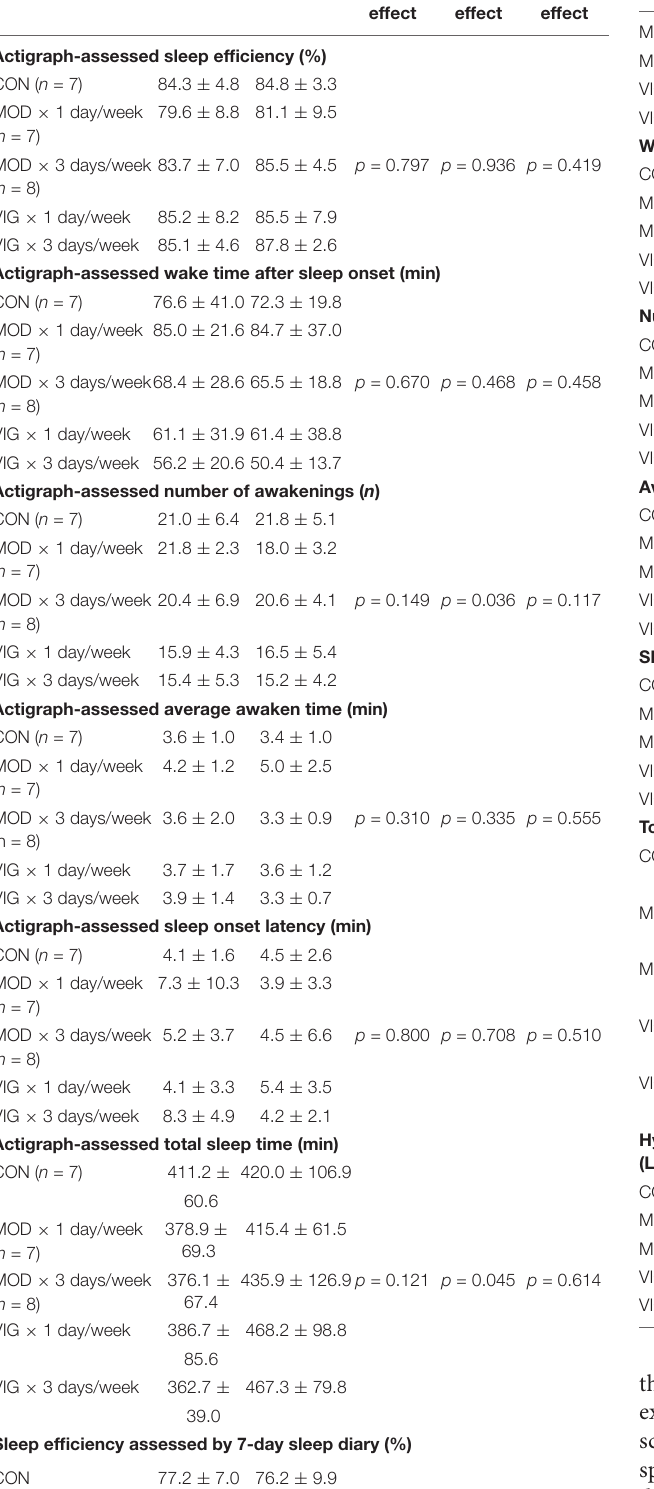
TABLE 2 | Summary of the objective sleep data assessed by actigraphy and the subjective sleep data measured by 7-day sleep diary.